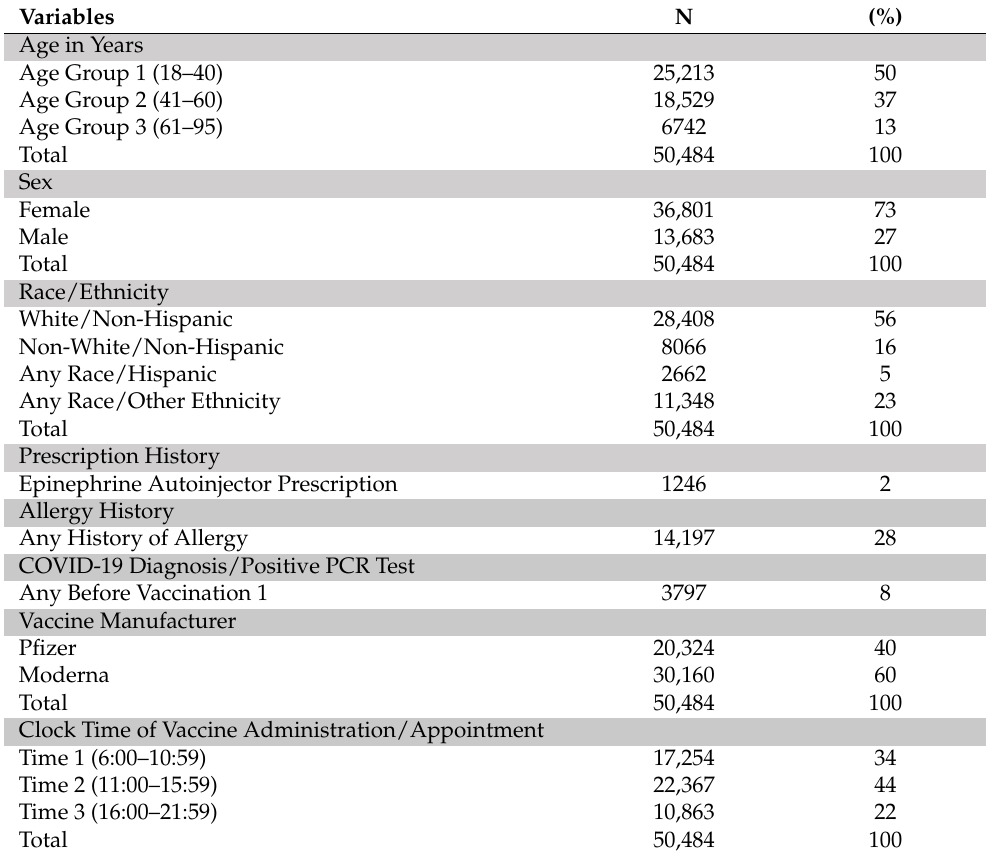
Table 1. N: number of individuals and (%) percent of total